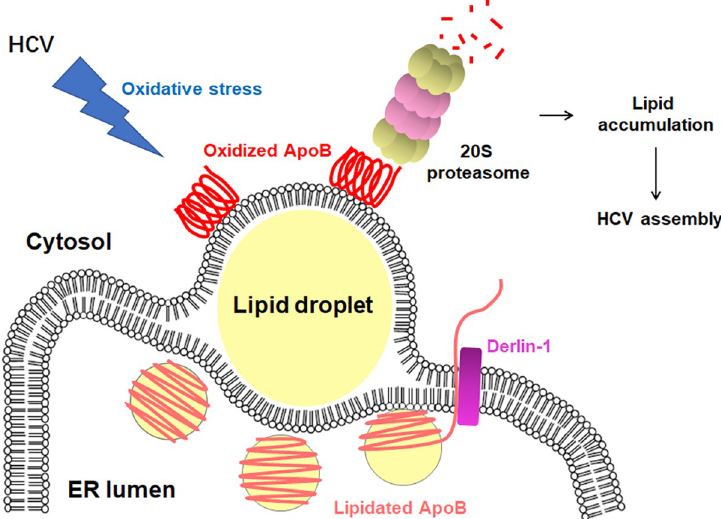
Fig 10. Schematic representation of ApoB degradation in HCV-infected Huh-7 cells. ApoB is retrotranslocated from the ER lumen to cytosolic LDs via a process requiring Derlin-1. HCV infection induces oxidative stress and results in ApoB oxidation. Oxidized ApoB is recognized and degraded by the 20S proteasome. The degradation of ApoB impairs lipid secretion and contributes to lipid accumulation, which might lead to enhanced HCV production.